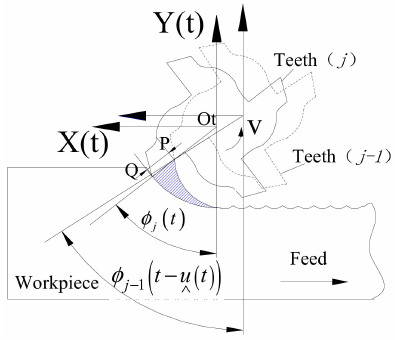
Figure 4. Model of undeformed chip thickness.